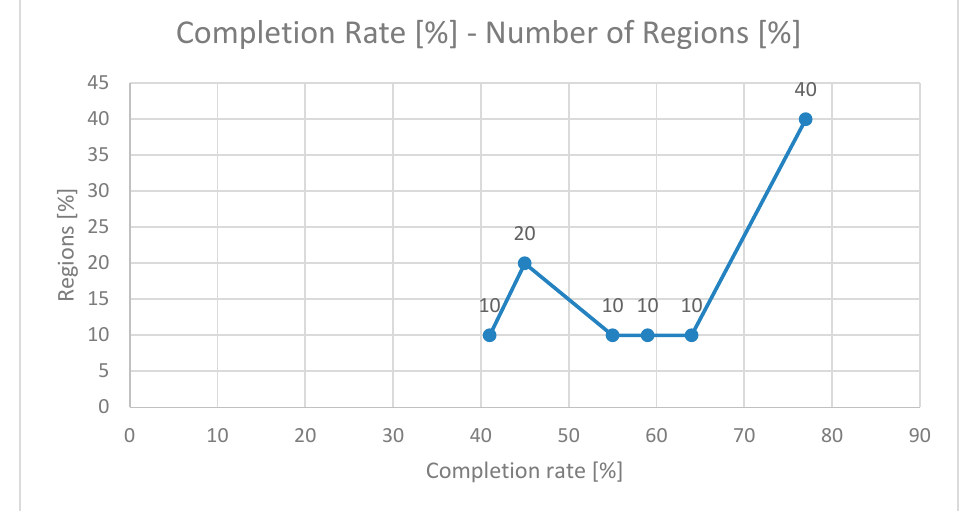
Figure 6. Overview of the work in progress of type plans in regions.